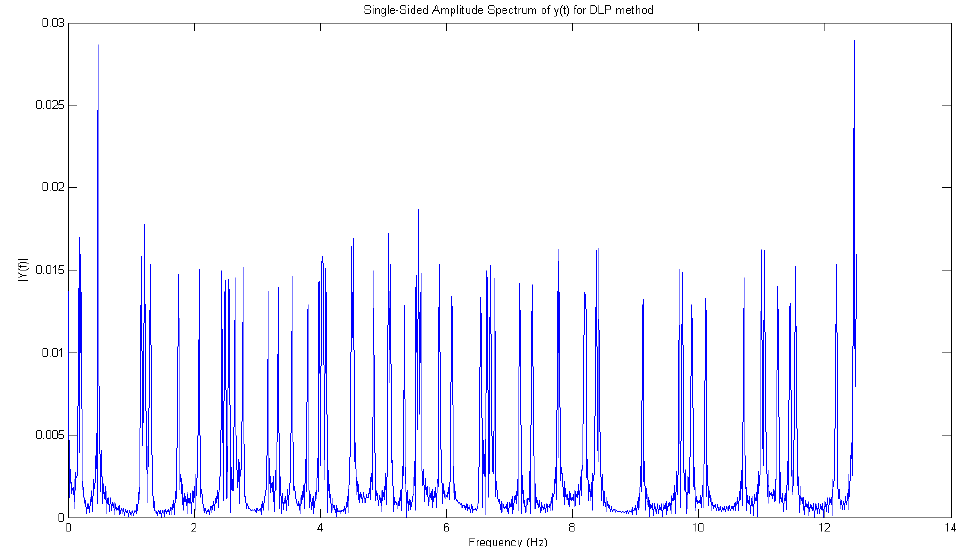
Figure 9. Frequency representation of all peaks (1–6) retrieved from the time domain using the DLP algorithm.